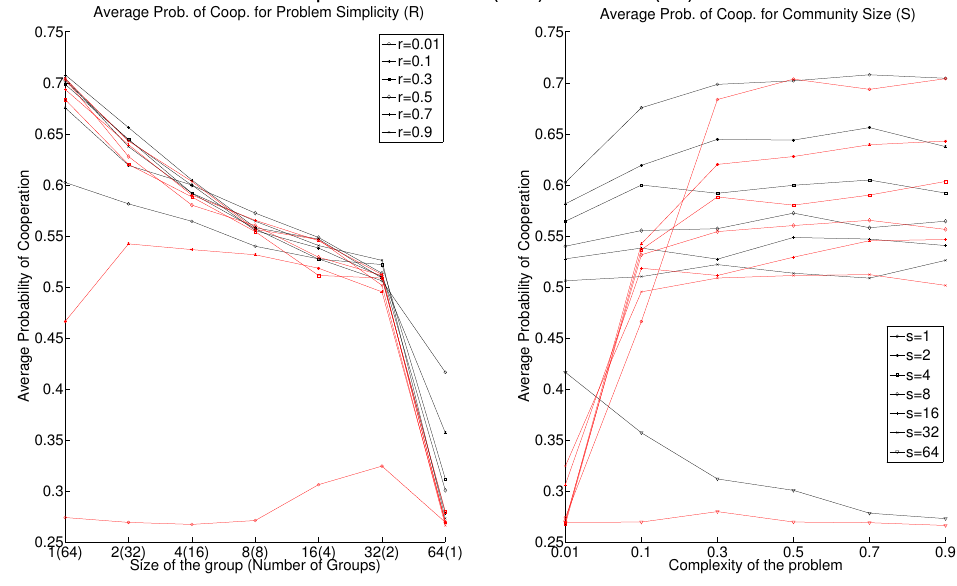
Figure 3. Comparison of the final average probability of cooperation for the condition with the cost of cooperation equal to 0 (dark lines) and the cost of cooperation equal to 10% (red lines), compared to the problem simplicity ( left plot), and to the group sizes ( right